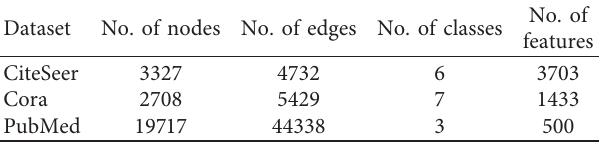
Table 1: The description of the citation network dataset. Dataset No. of nodes No. of edges No. of classes